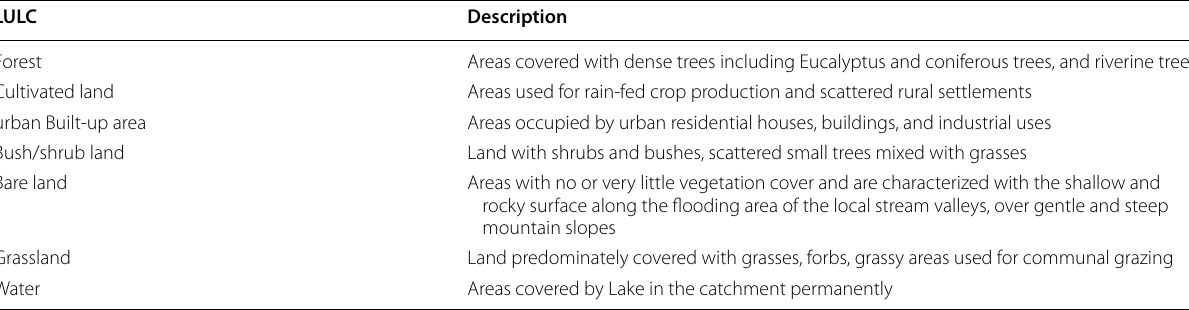
Table 1 Description of land use and land cover categories considered in image classification LULC Description Forest Cultivated